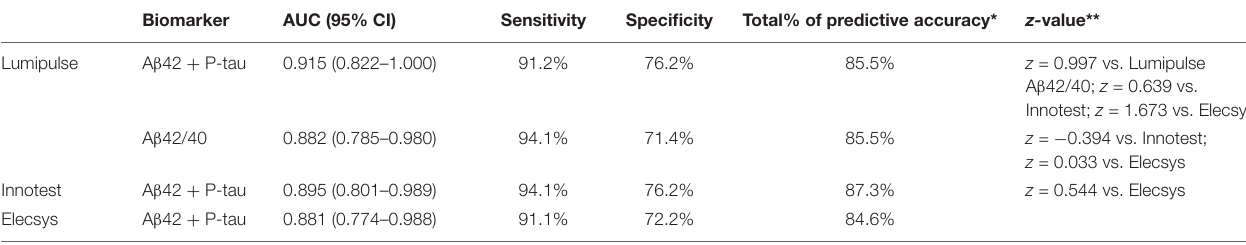
AUC, Area under the curve. *The percentage of correct classification of AD + correct classification of non-AD/all cases. **Values of |z| < 1.96 were taken as evidence that the true ROC areas were not different.